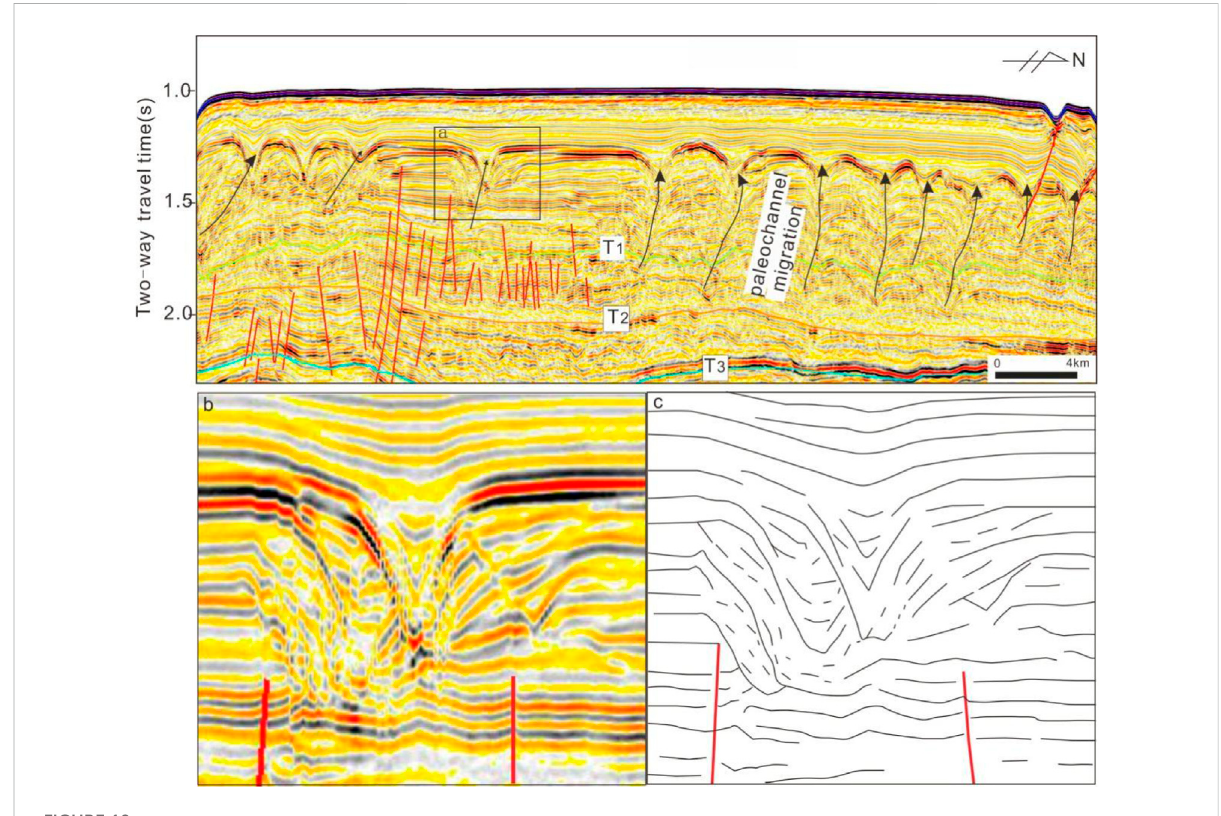
FIGURE 10 Seismic pro fi le of buried paleochannel migration, where (B) is the enlarged part of (A, C) is the fi ne description of the internal structure of